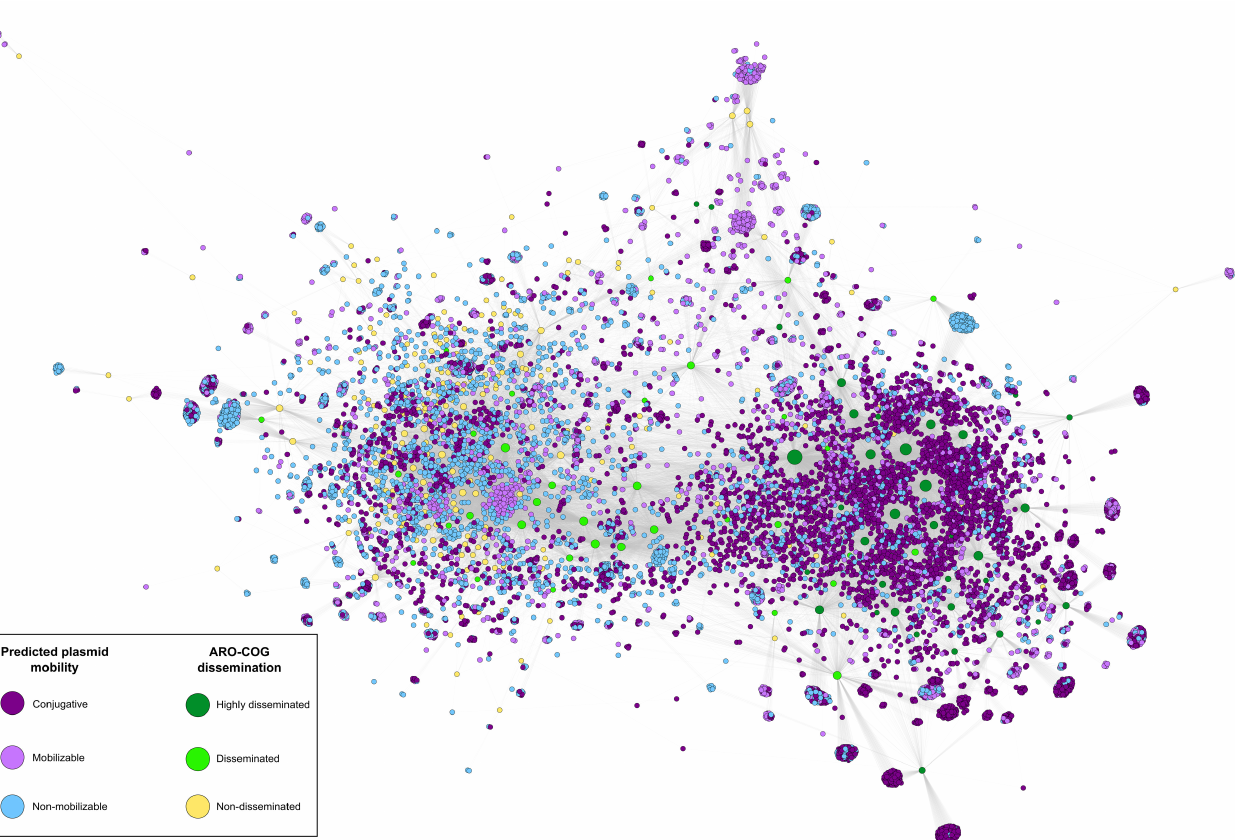
Figure 7. Bipartite network illustrating the correlation between predicted plasmid mobility and ARG dissemination. Plasmid mobility was predicted using the MOB_suite. “Highly disseminated” denotes ARO-COGs with DI > 75%, “Disseminated” stands for ARO-COGs with 0% > DI > 75% and “Non-disseminated” for ARO-COGs with DI = 0%. An interactive version of the network is available at https://miquelsanchezosuna.github.io/arg_gc_network/ (accessed on 14 December